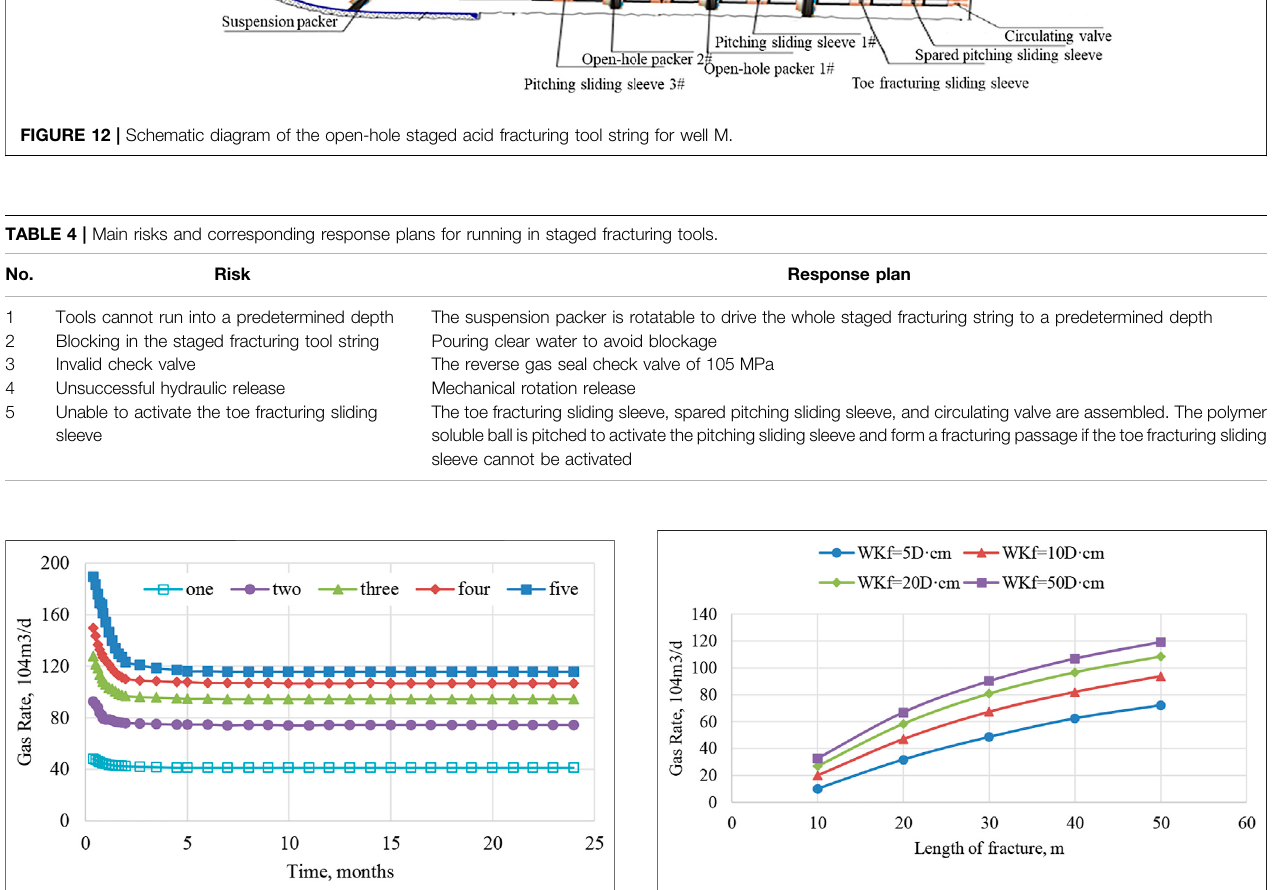
FIGURE 14 | Productivity performance versus fracture lengths and